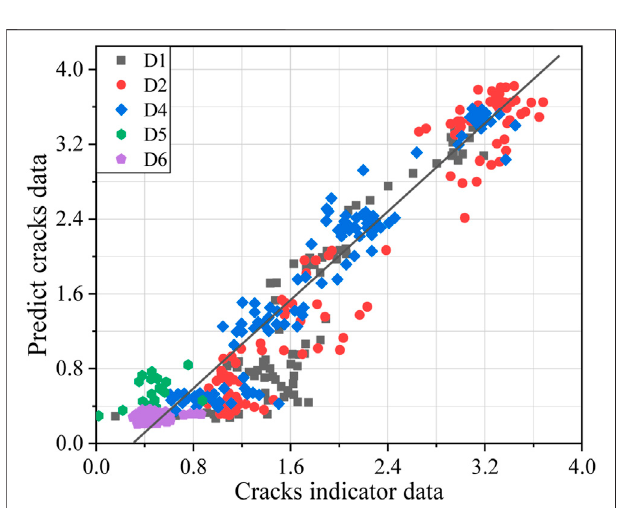
FIGURE 8 | PNN inversion similarity coef fi cient (the similarity coef fi cient is